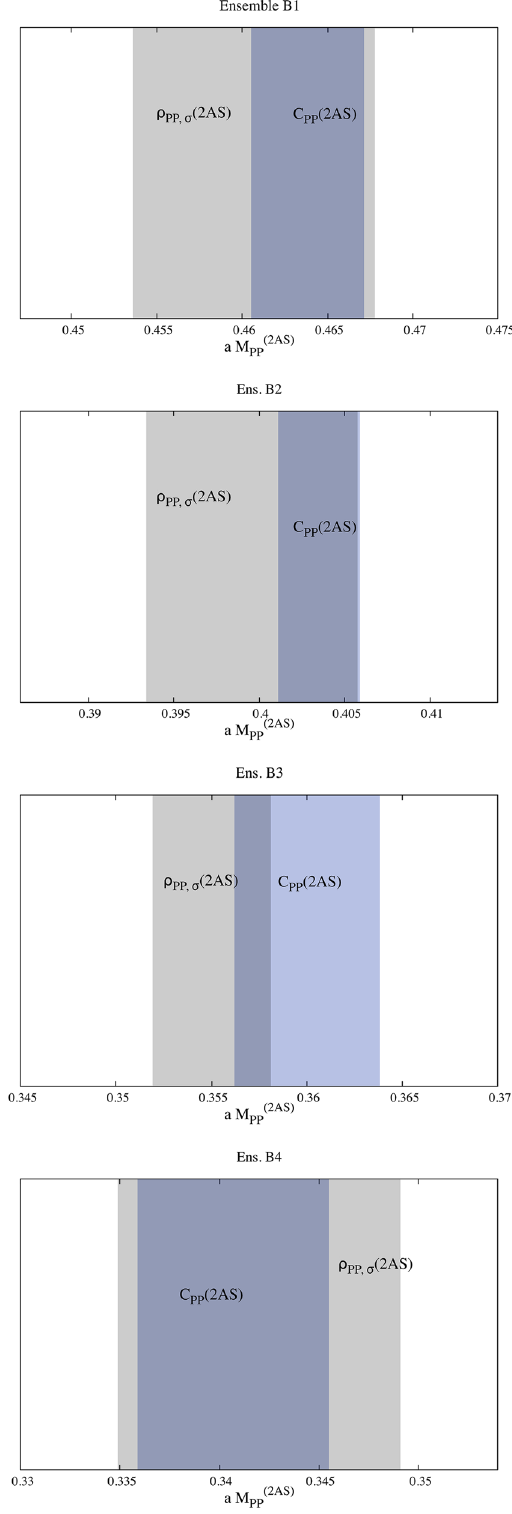
Fig. 14 Graphical comparison between the two predictions for aM ( 2AS ) for the ensembles PP